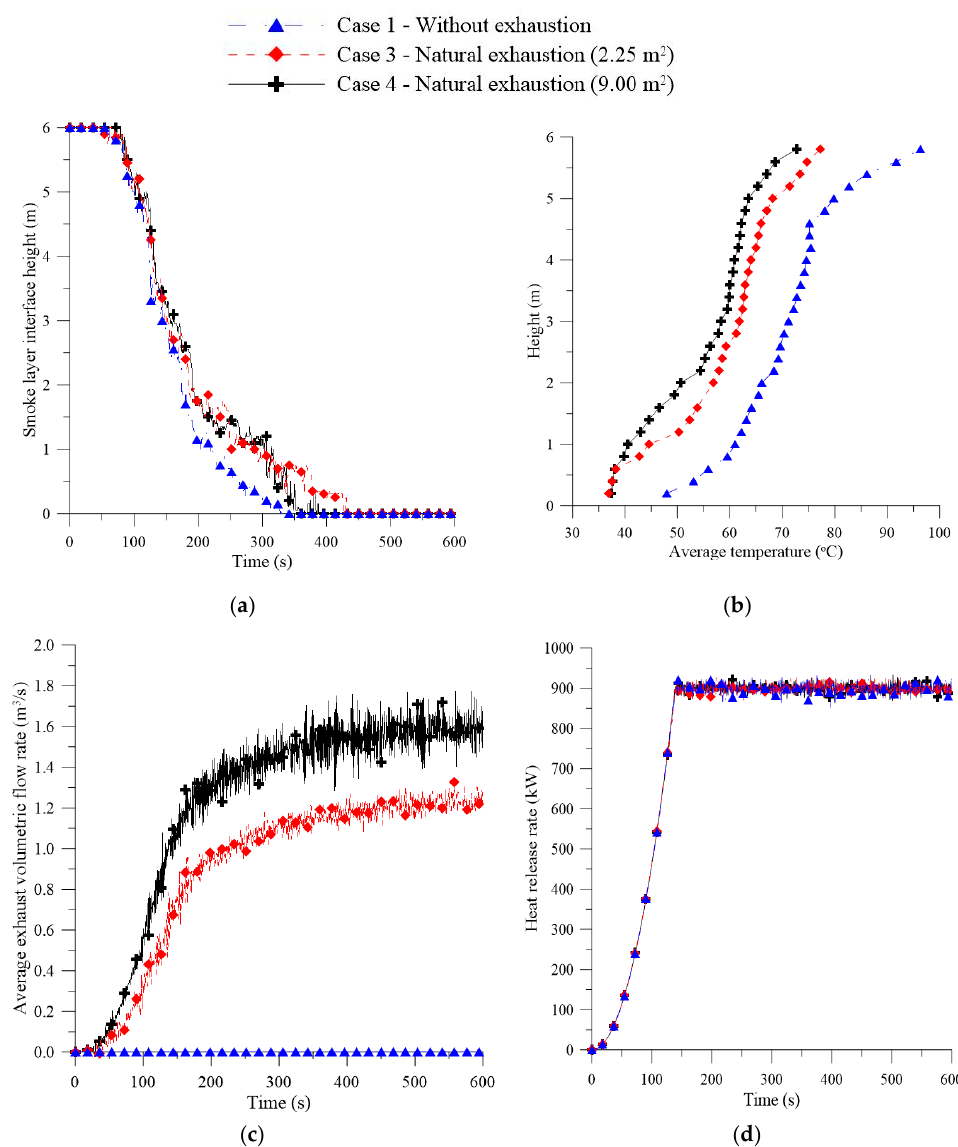
Figure 6. Influence of the natural exhaust area in the ( a ) smoke layer vertical displacement; ( b ) average temperature profile at t = 600 s; ( c ) average exhaust volumetric flow rate and ( d ) HRR (compartment with closed windows and HRR = 900 kW).